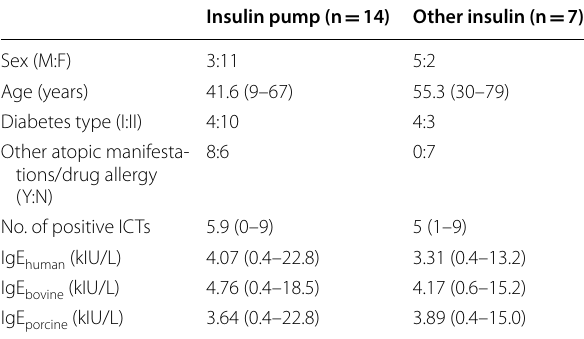
Table 2 Comparison of patient characteristics and